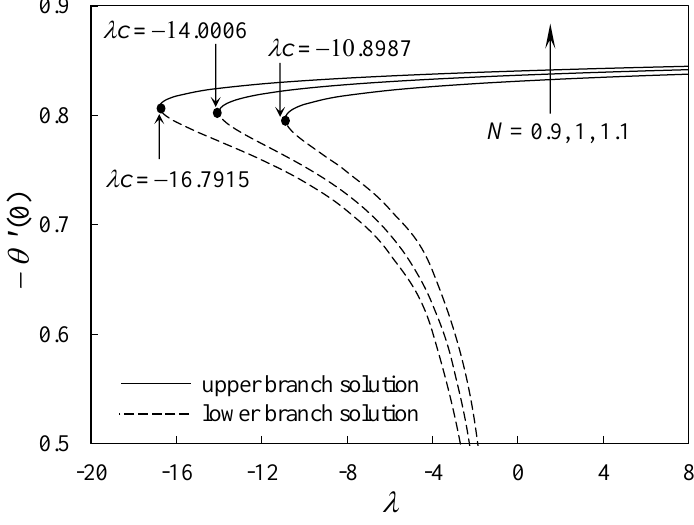
  0  (cid:48) ( 0 ) with λ for several values of N for Ag-water   0  with  for several values of N for Ag-water nanofluid. Figure 7. Variation of − θ with  for several values of N for Ag-water nanofluid.